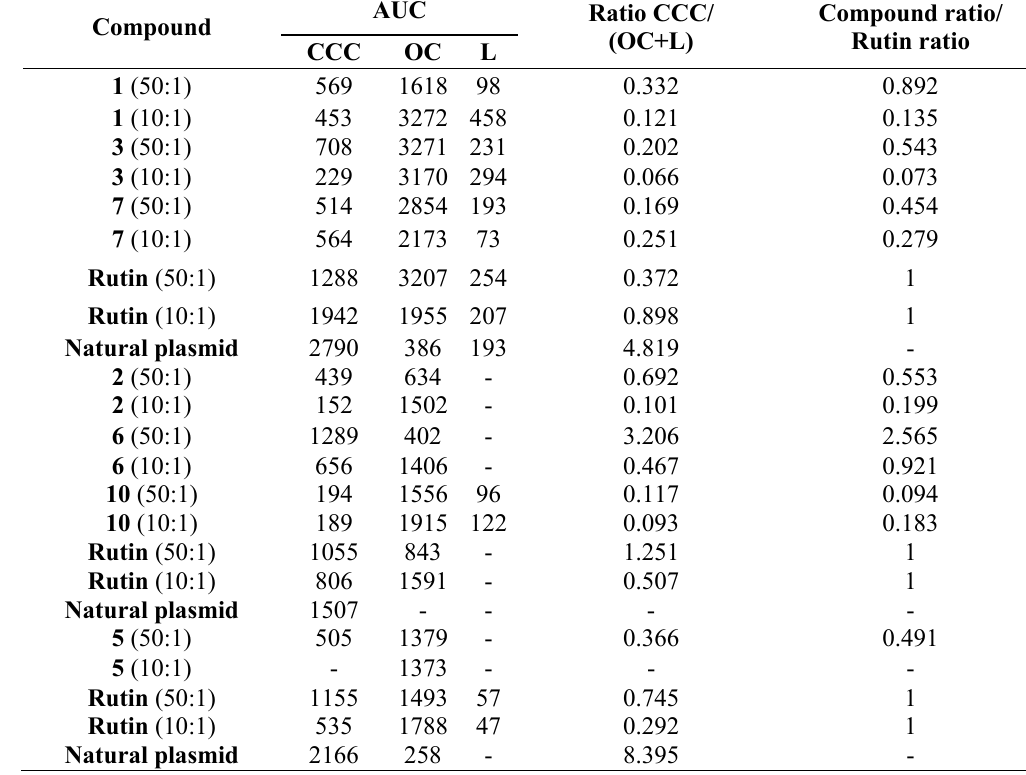
Table 3. Results of Fenton reaction inhibition assay. Rutin at the molar excess of 50:1 or 10:1 to DNA base pare was compared with the tested compounds at the same molar